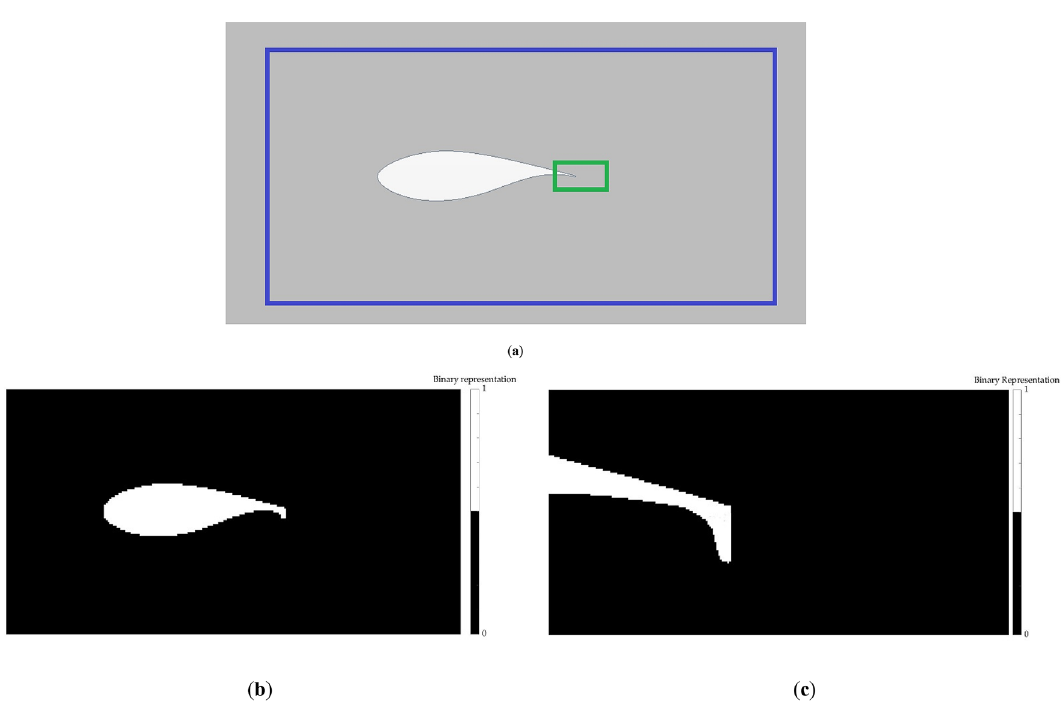
Figure 4. Domain representation layers of a Gurney flap: ( a ) sketch of the area represented by each layer (airfoil overview layer marked in blue and flow control device close-up layer marked in green); ( b ) airfoil overview layer; ( c ) close-up view of the flow control device